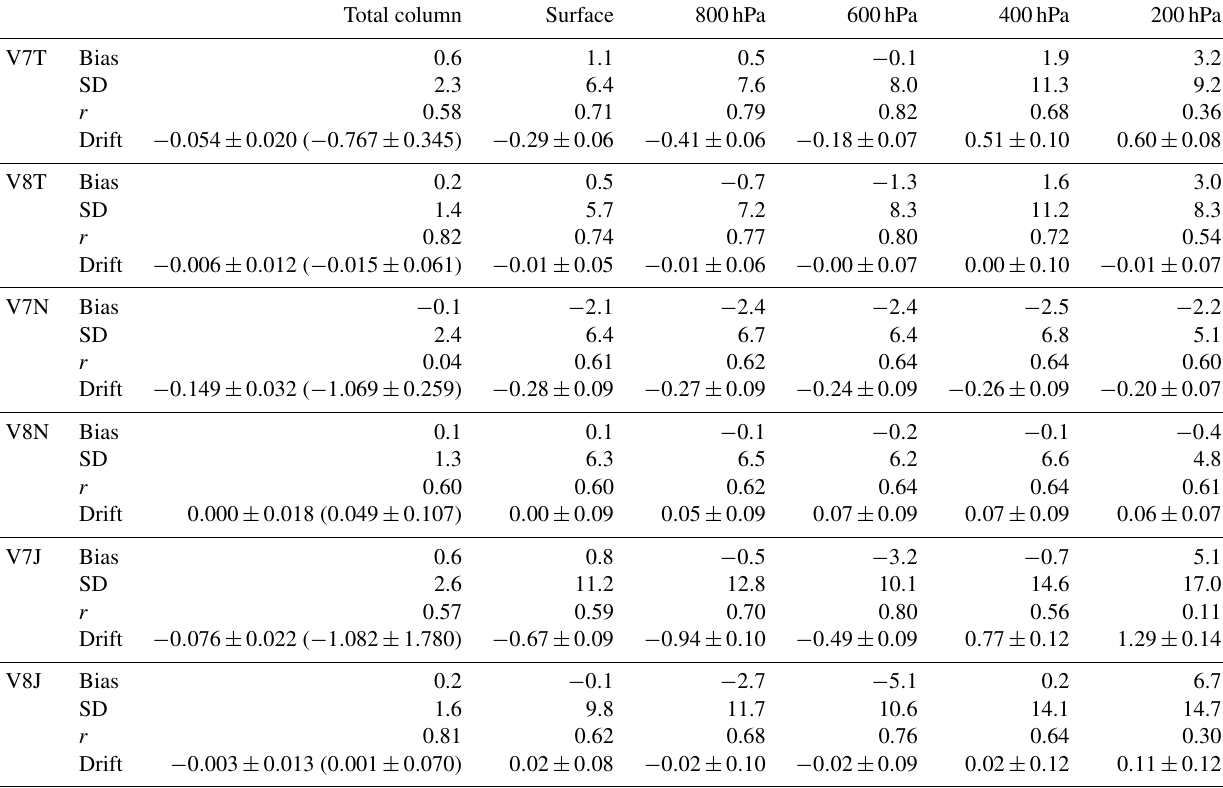
Table 3. Summarized validation results for V7 and V8 TIR-only (V7T and V8T), NIR-only (V7N and V8N), and TIR–NIR (V7J and V8J) products based on in situ data from NOAA aircraft validation sites. Bias and standard deviation (SD) statistics for the total column are in units of 10 17 molec.cm − 2 . Bias and SD for retrieval levels are expressed in percent (%). Total column drift values are provided in units of both 10 17 molec.cm − 2 yr − 1 and percent per year (%yr − 1 , in parentheses). Drift for the retrieval levels is expressed in percent per year (%yr − 1